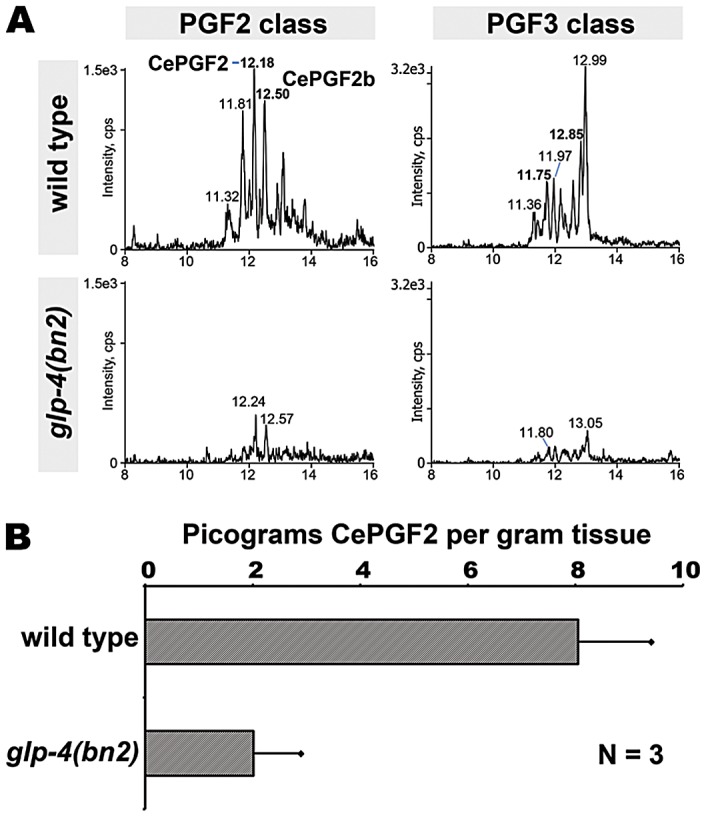
Prostaglandins in adult wild type and germline-deficient glp-4 mutants.(A) MRM chromatograms of synchronized 1–2 day adult wild-type and glp-4(bn2) mutants. The F2 class was detected with mass transition m/z 353/193 and the F3 class was detected with mass transition m/z 351/193. Liquid chromatography retention time (min) is shown on the X-axis and for selected prostaglandin isomers. Cps, counts per second. (B) CePGF2 quantification in wild-type and glp-4 mutant extracts. Error bars are SD.